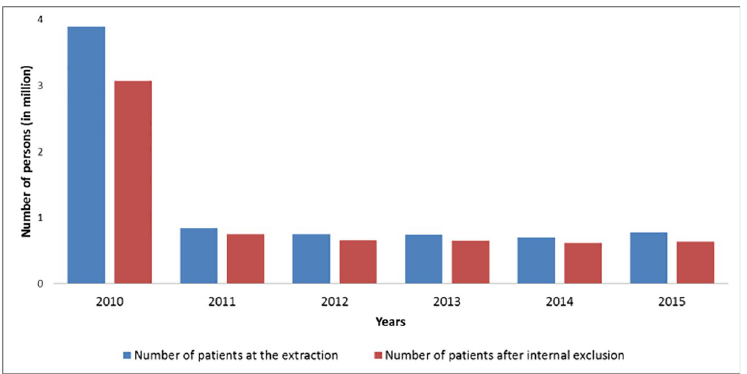
Fig 2. Number of patients included in the cancer cohort between 2010 and